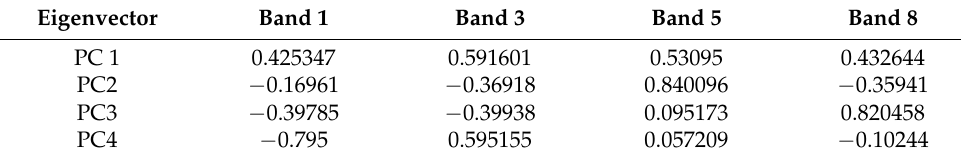
Table 12. Eigenvector loading for PC bands 1, 3, 5, and 8.